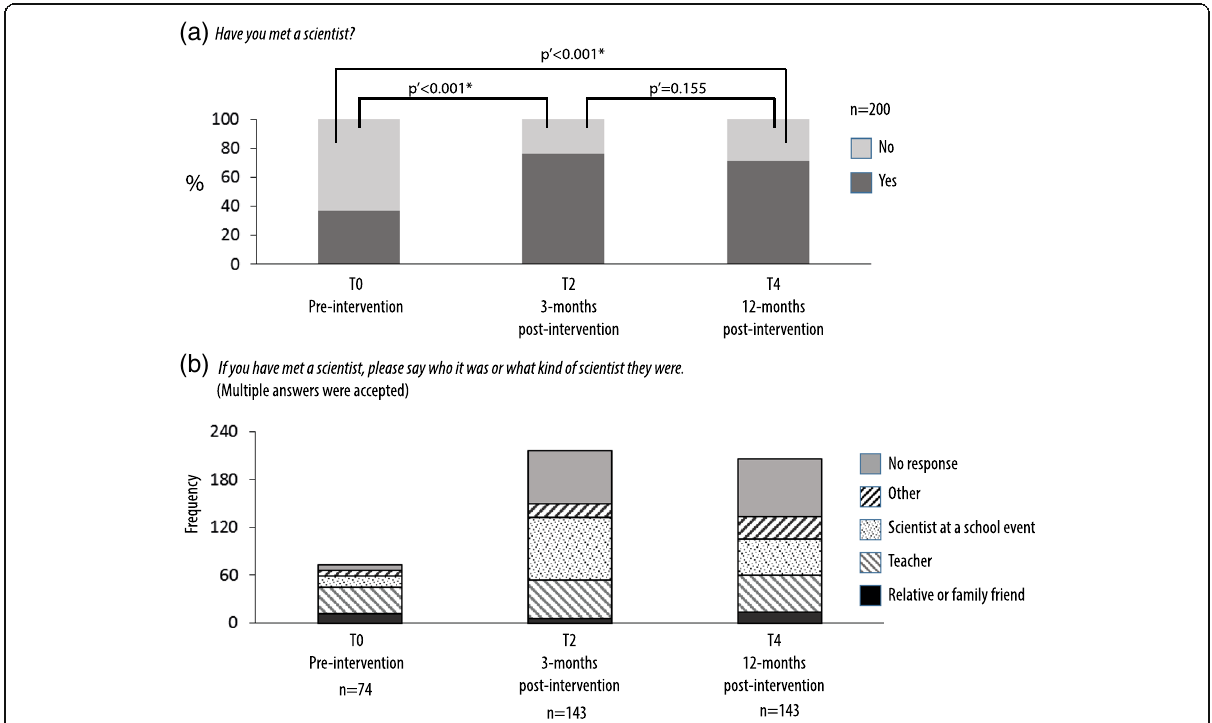
Fig. 4 Experiences of meeting scientists. Matched pre-post responses, n = 201. a Matched pre-post responses to statement 7. Have you met a scientist? Variance in distribution of matched responses at T0, T2, and T4 was measured using the Cochran ’ s Q test, Q = 98.255, p < 0.001. Post hoc pairwise comparisons shown on the figure were conducted using McNemar ’ s test. The Bonferroni-Holm ’ s correction for multiple comparisons was applied. Binomial logistic regression demonstrated no significant difference between the responses of boys and girls. b Matched pre-post responses to statement 8. If you have met a scientist, please say who it was or what kind of scientist they were? Variance in the frequency of responses in each category was measured using the Chi-Squared test, χ 2 (8) = 53.48, * p < .